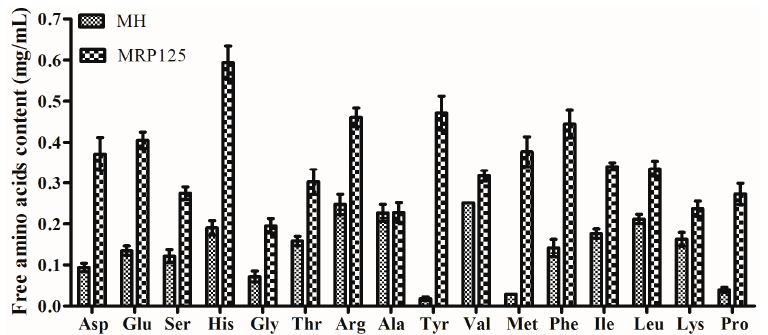
Figure 4. Content of free amino acids in mushroom hydrolysate (MH) and Maillard reaction products prepared at 125 °C (MRP125).